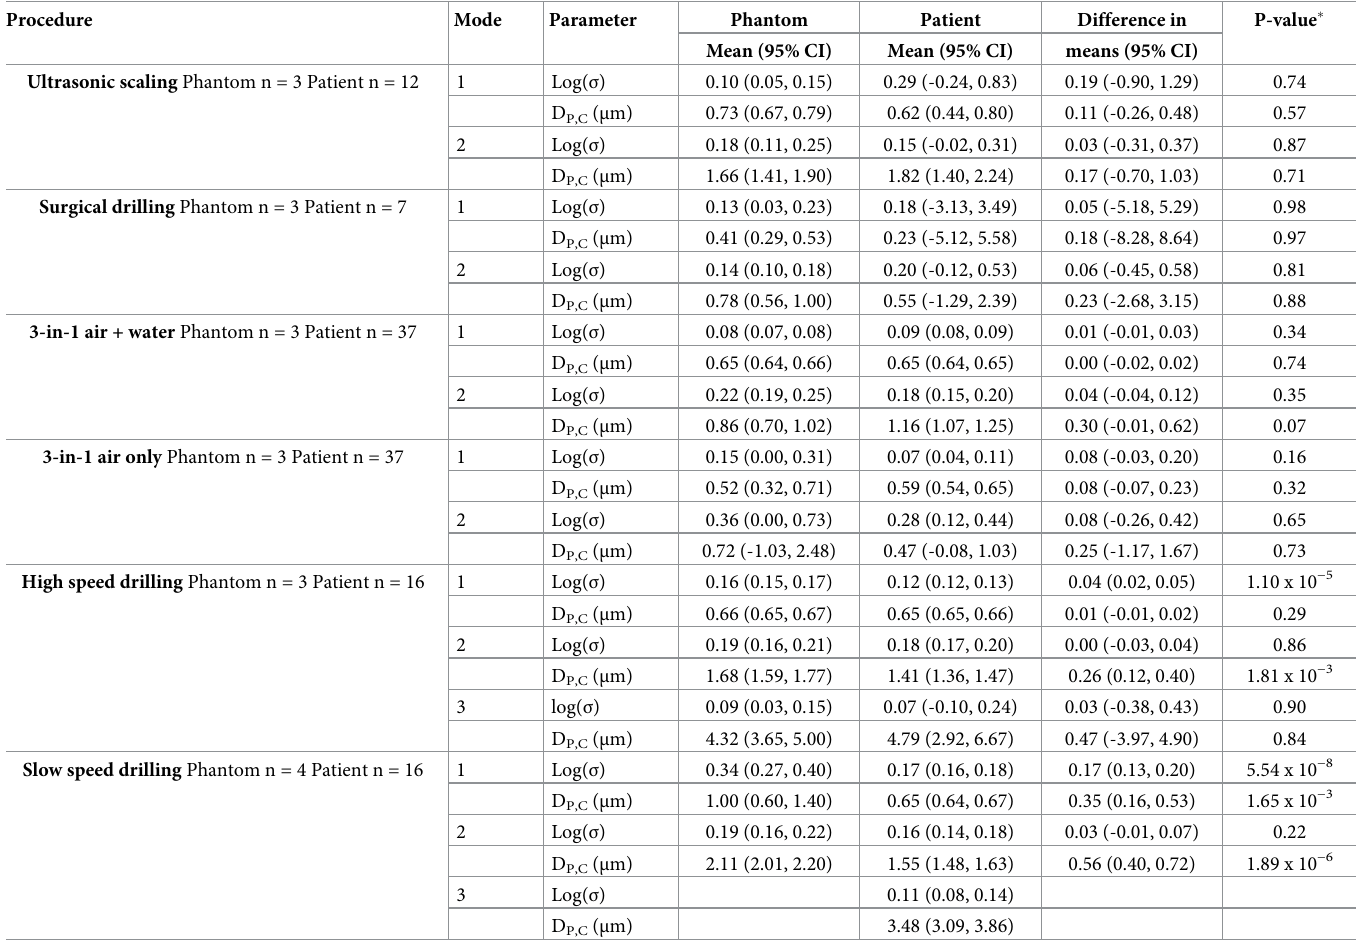
Table 2. A comparison of aerosol size distribution parameters between the phantom control and patient